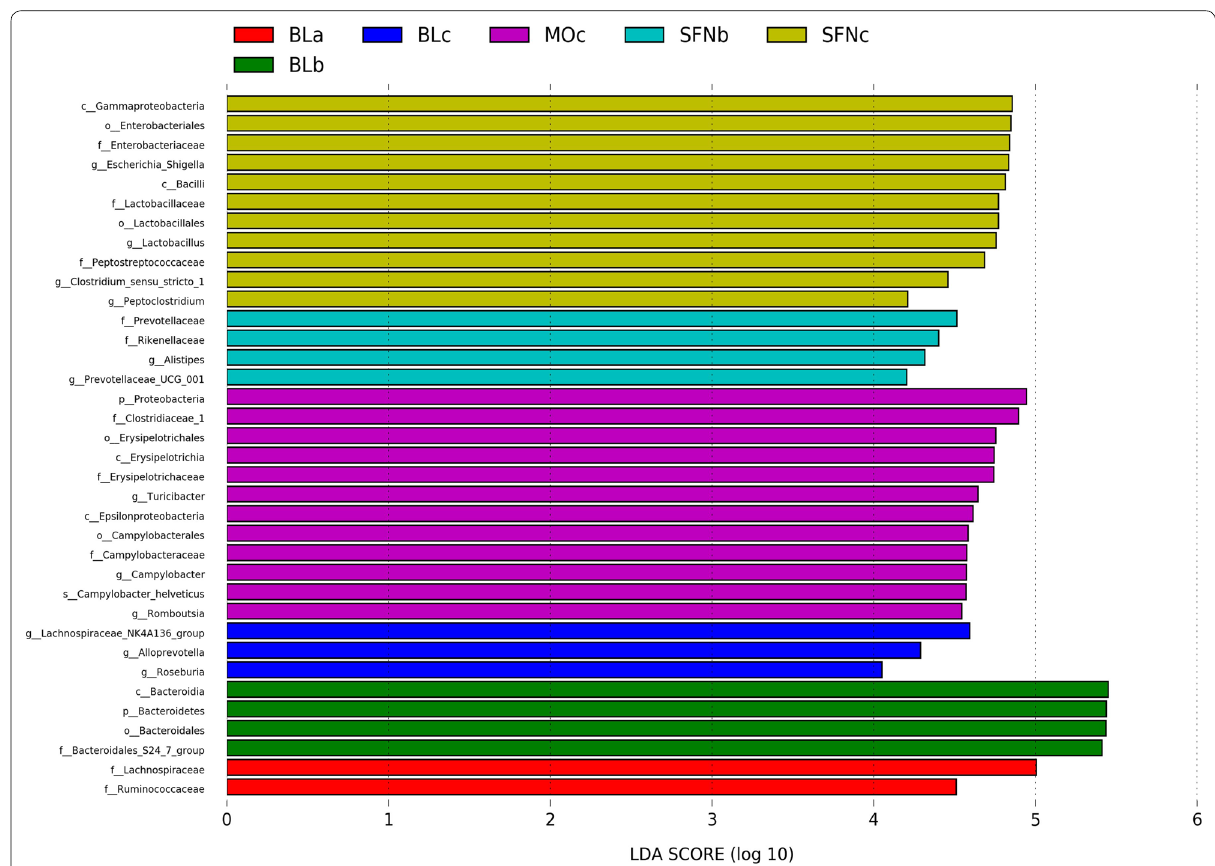
Fig. 5 Comparison of species with significant difference in abundance among the three groups of mice by lefse analysis